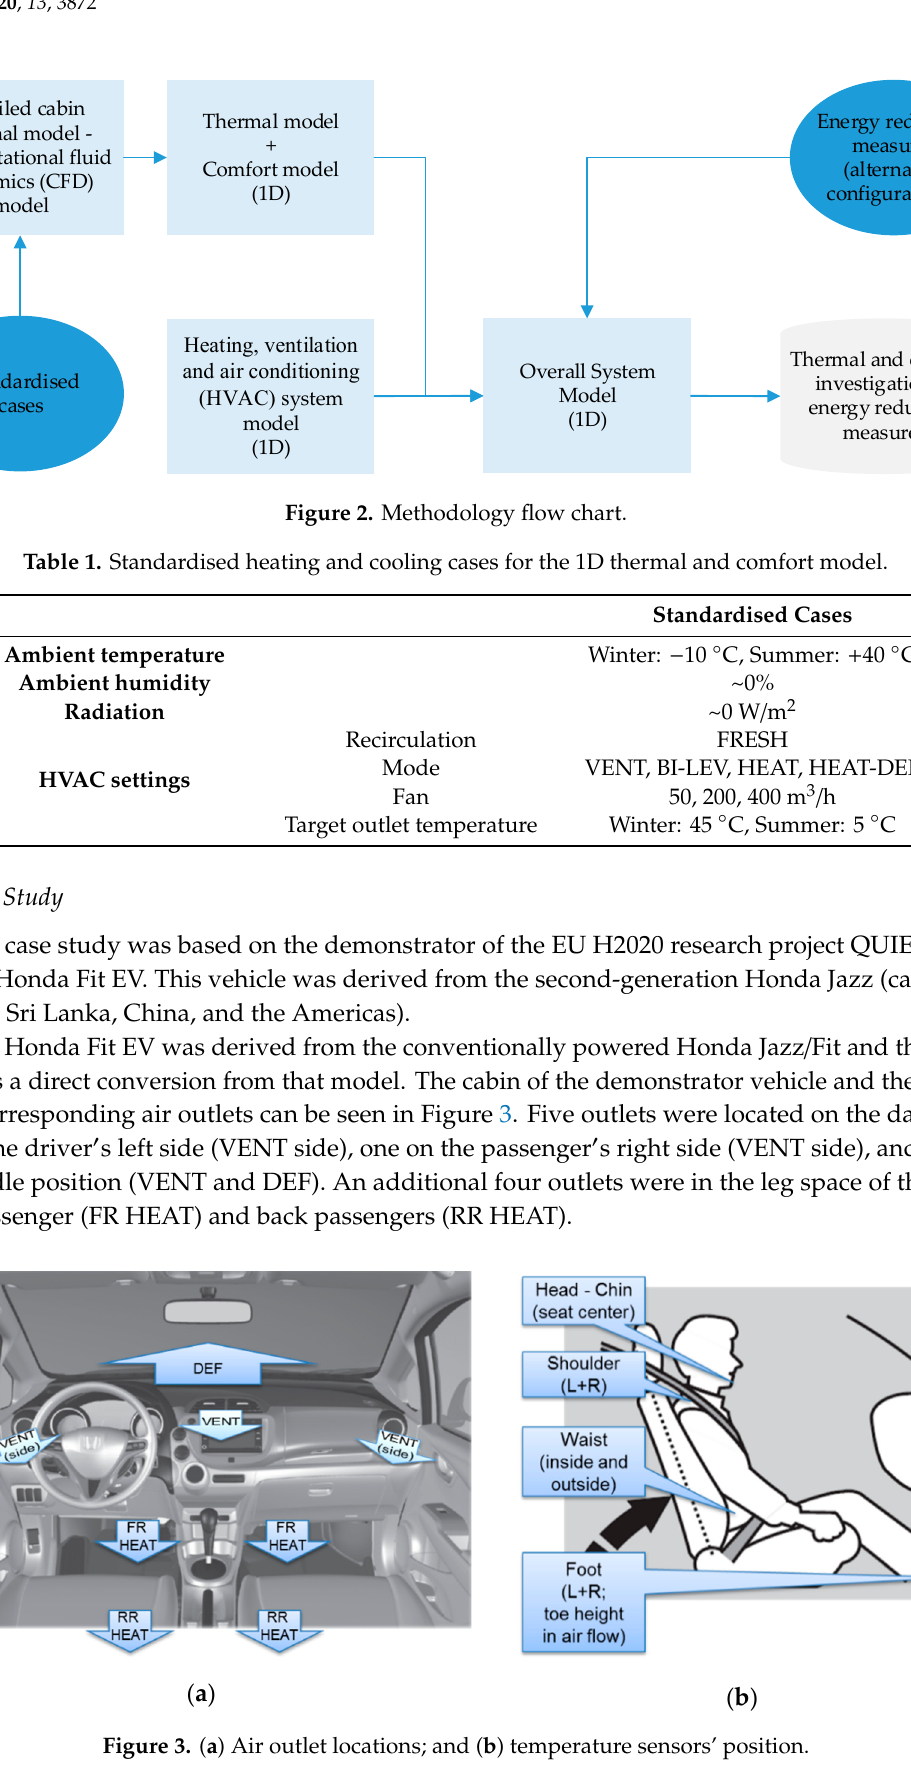
Table 2. Air flow distribution ratios. Mode